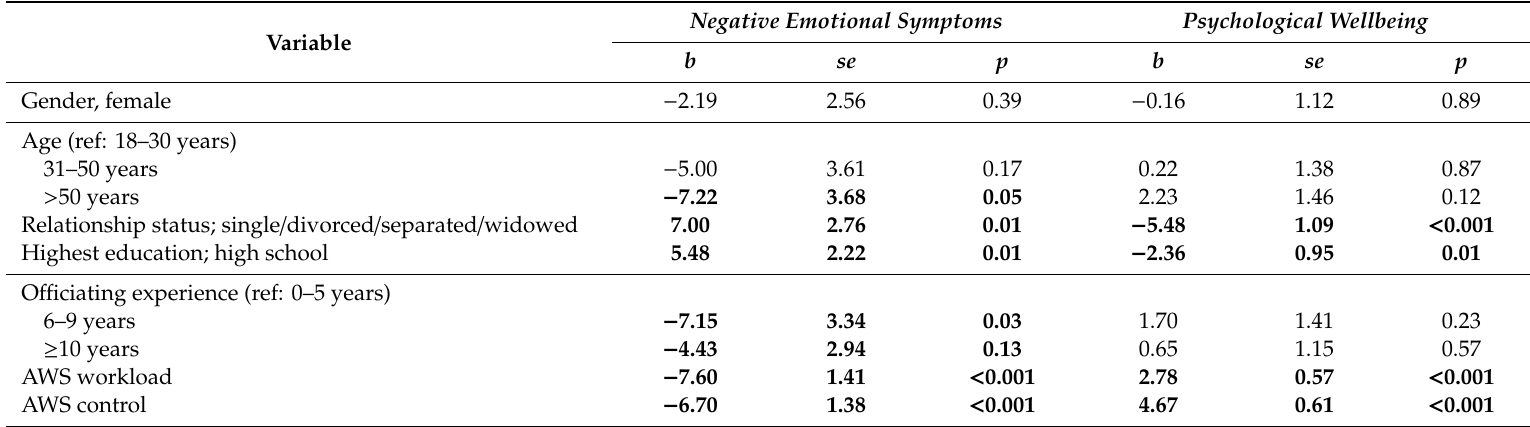
Table 4. Multivariate models predicting negative emotional symptoms (DASS composite score) and psychological wellbeing (WEMWBS total score). Negative Emotional Symptoms Psychological Variable